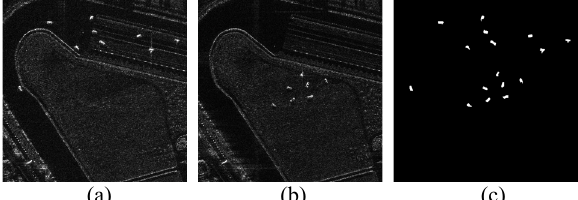
Figure 7. Multi-temporal images of Beijing. (a) Master image. (b) Slave image. (c) Ground-truth.